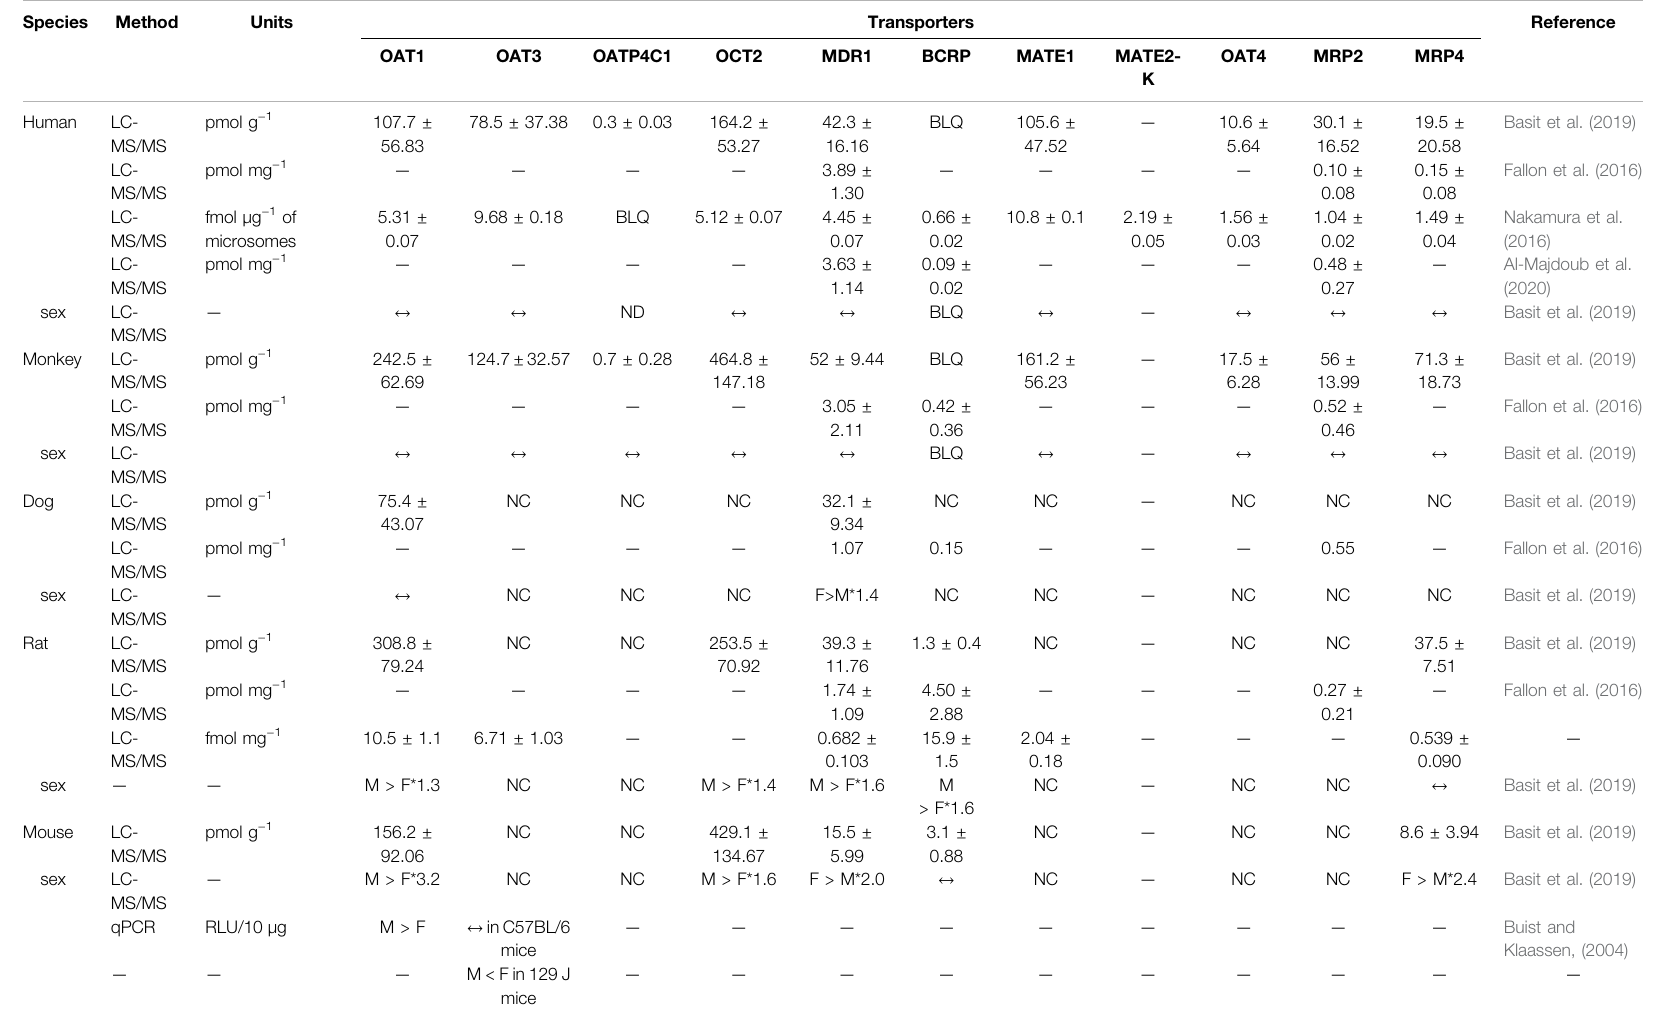
TABLE 2 | The expressions of main drug transporters in different species and sex-genders. Species